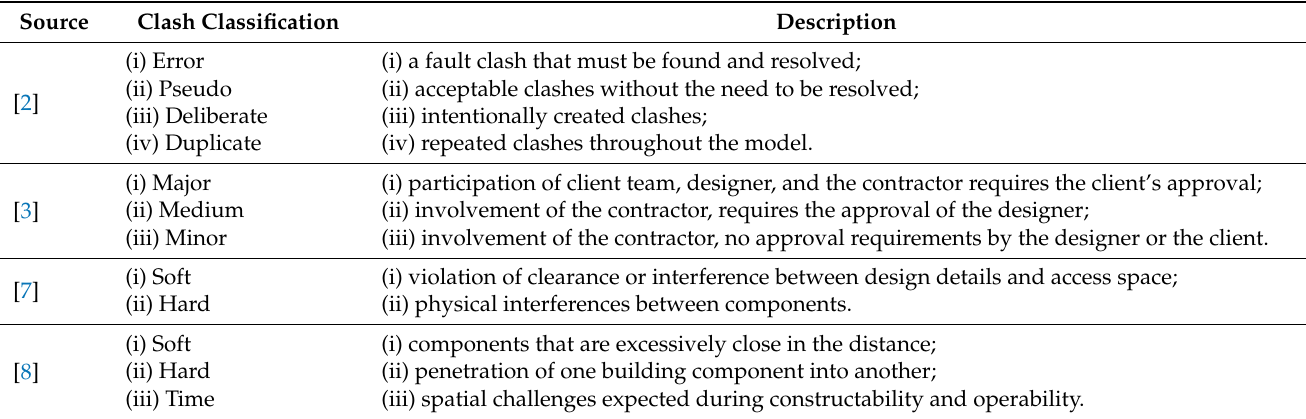
Table 1. Clash classification in the